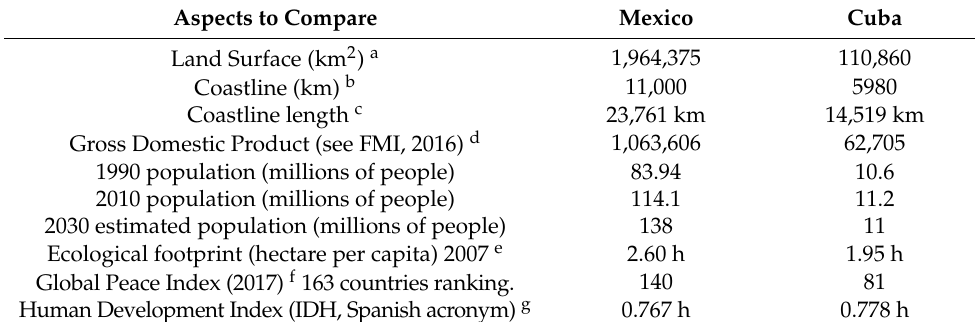
Table 3. Relevant comparative aspects between Mexico and Cuba. Aspects to